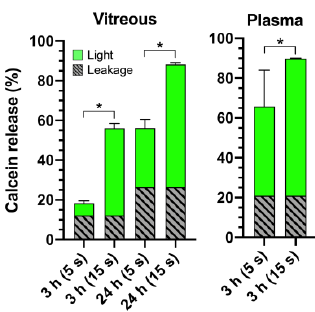
Figure 3. Light-activated release from HA-coated liposomes with 5 s and 15 s light exposures (800 nm